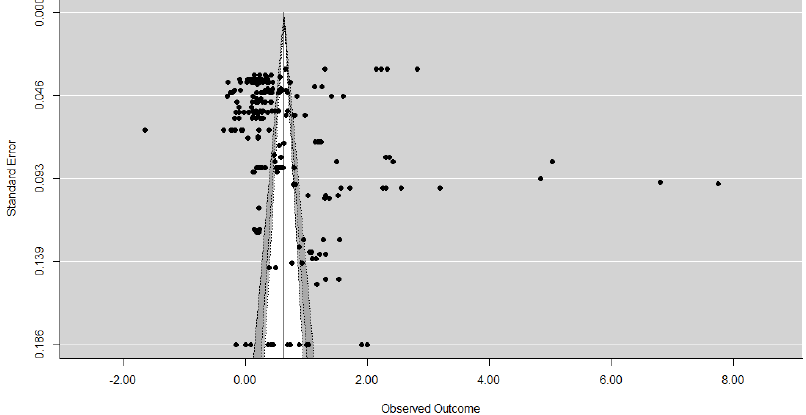
Figure 2. A contour enhanced funnel plot for complete case values ( n = 227). Light grey is <1% significance, medium grey is 1%–<5% significance, dark grey is 5%–10% significance, and the white is the area of non-significance.